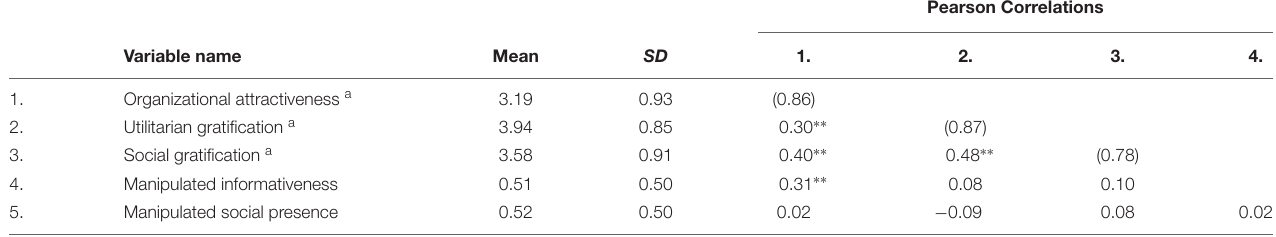
TABLE 2 | Means, Standard Deviations, Correlations, and Cronbach Alphas.